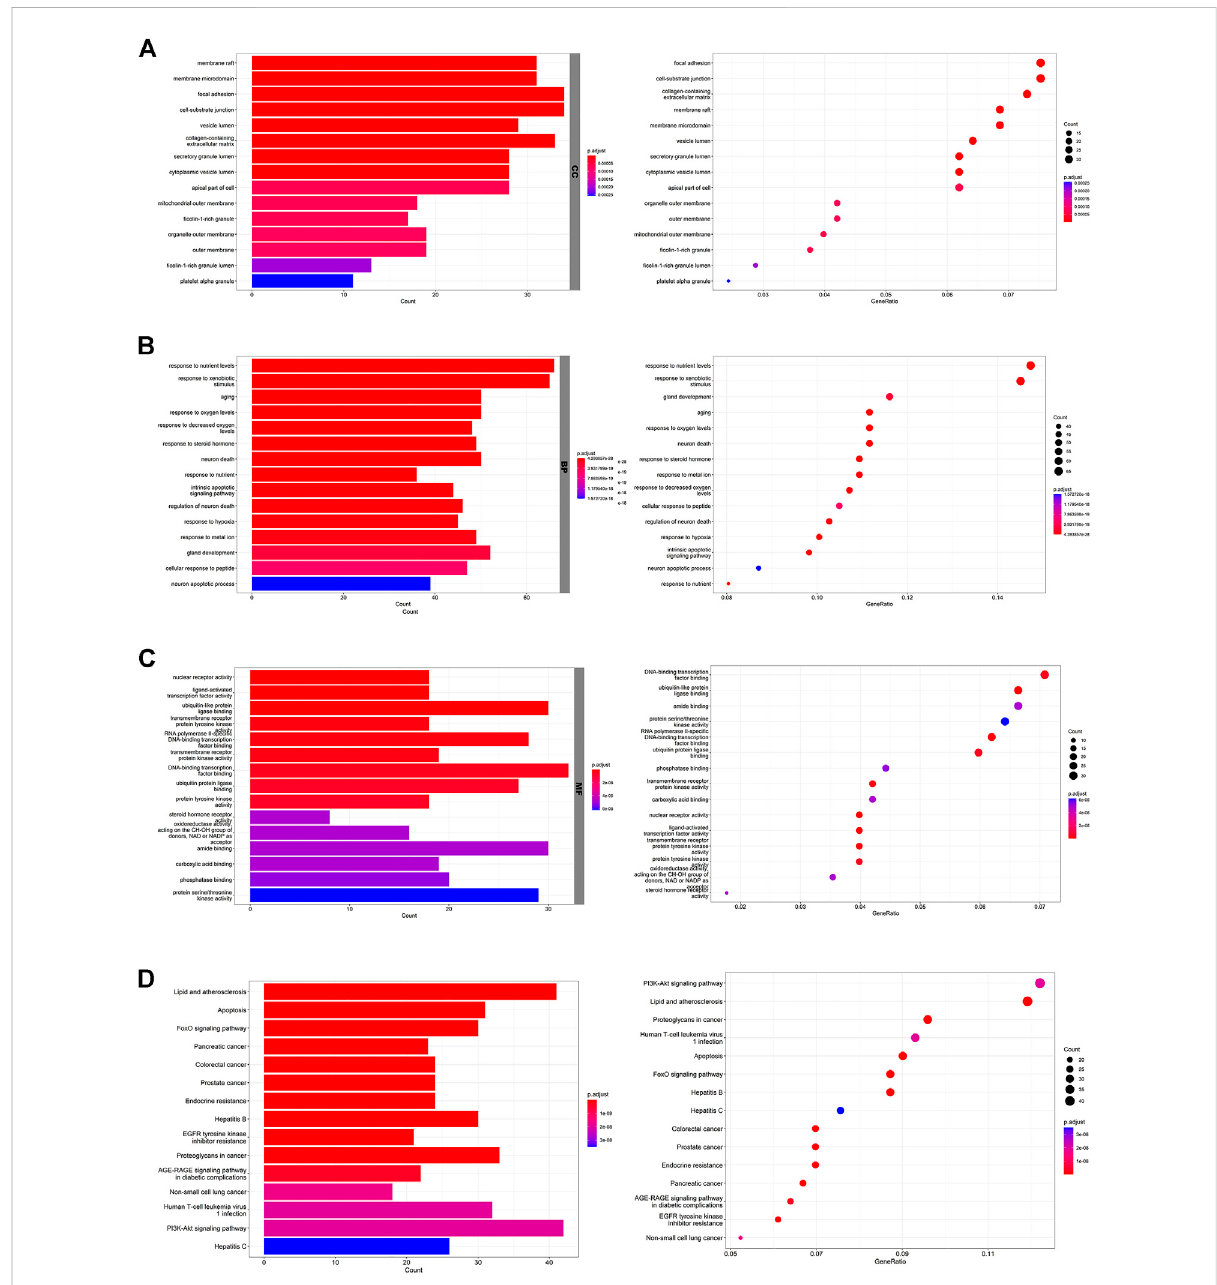
FIGURE 2 Biological function analysis ofthepotential targets. (A) Thetop 15GO termsintheCCcategory. (B) The top 15GO termsintheBPcategory. (C) The top 15 GO terms in the MF category. (D) The top 15 KEGG